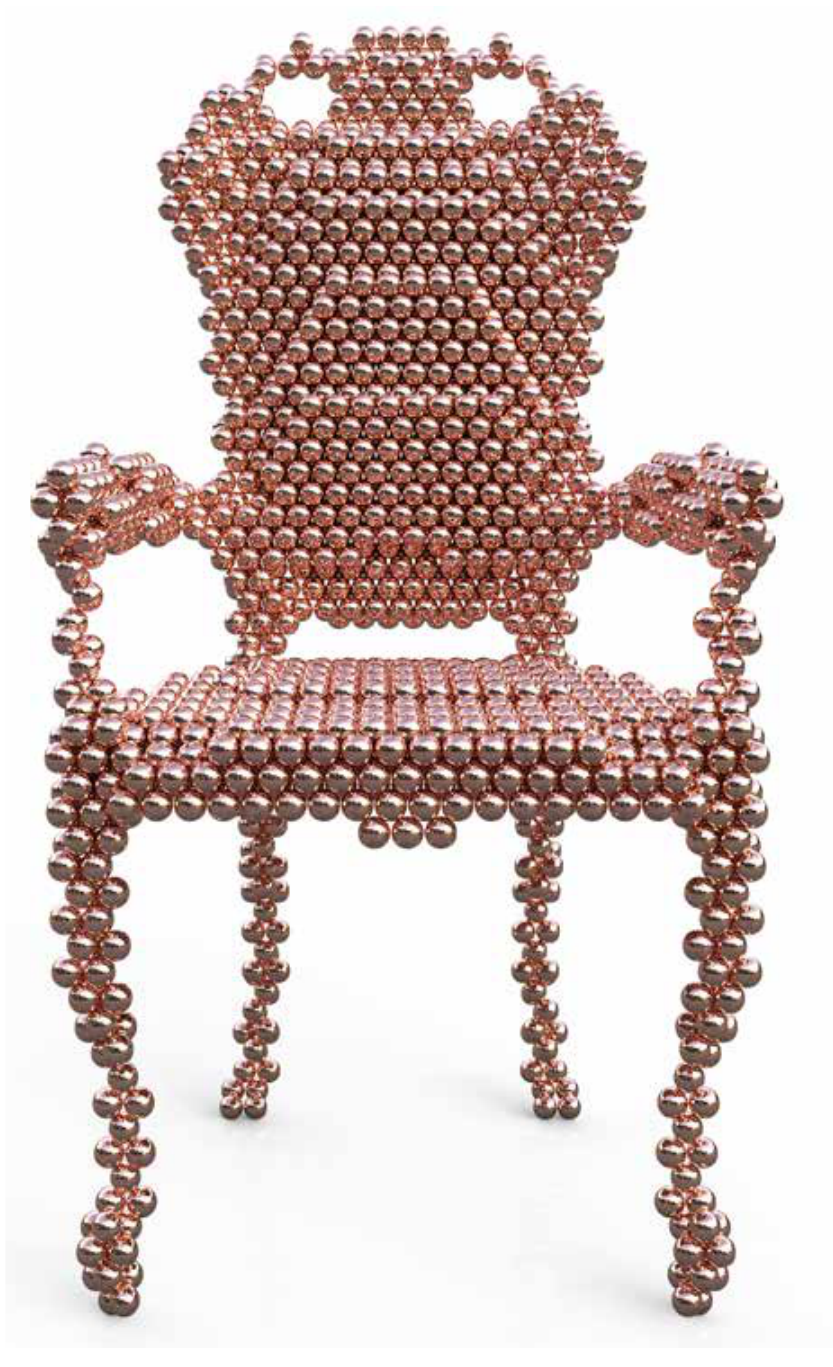
Figure 23 & 24 (top to bottom, opposite): Space-filler (2007). ABS Plastic. Design: Daniel Widrig Studio. Source: author.